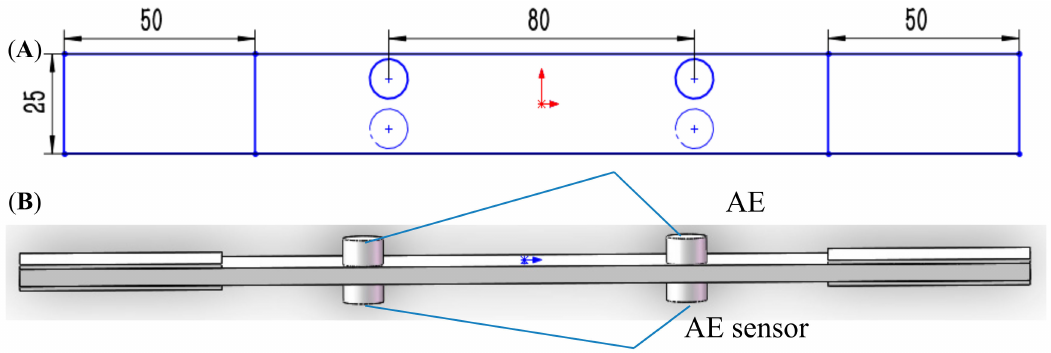
Figure 1. Design and resin transfer molding (RTM) curing process of a 3D braided composite [25]. 1 and 2: upper and lower molds, respectively; 3: mold sealing device; 4: storage tank and entry point of resin and curing agent; 5: non-infiltrated fabric; 6: fabric that has been impregnated with resin; 7 and 8: storage bins for resins and curing agents, respectively.